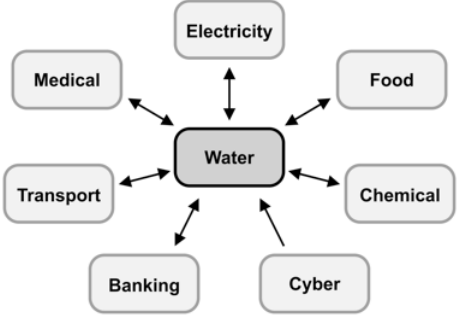
Figure 2: Dependency of water critical infrastructure on other